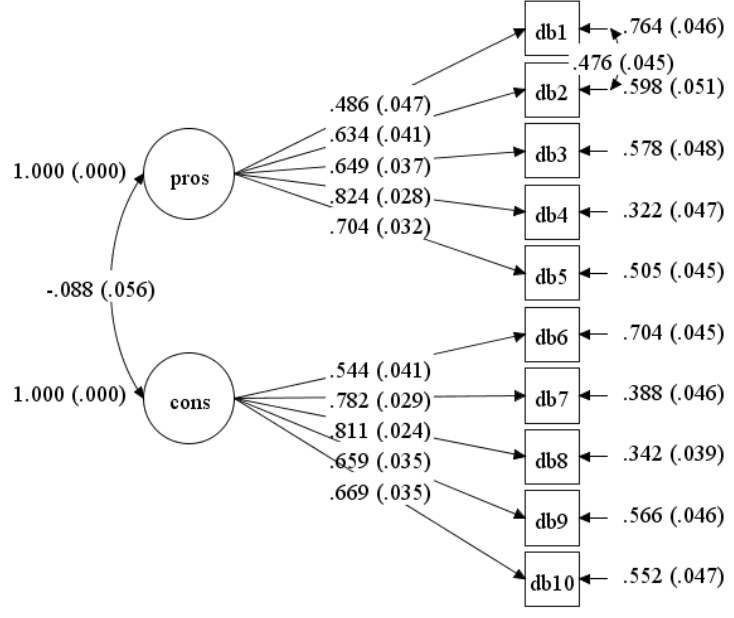
Figure 2. Standardised item loading for Model-2.